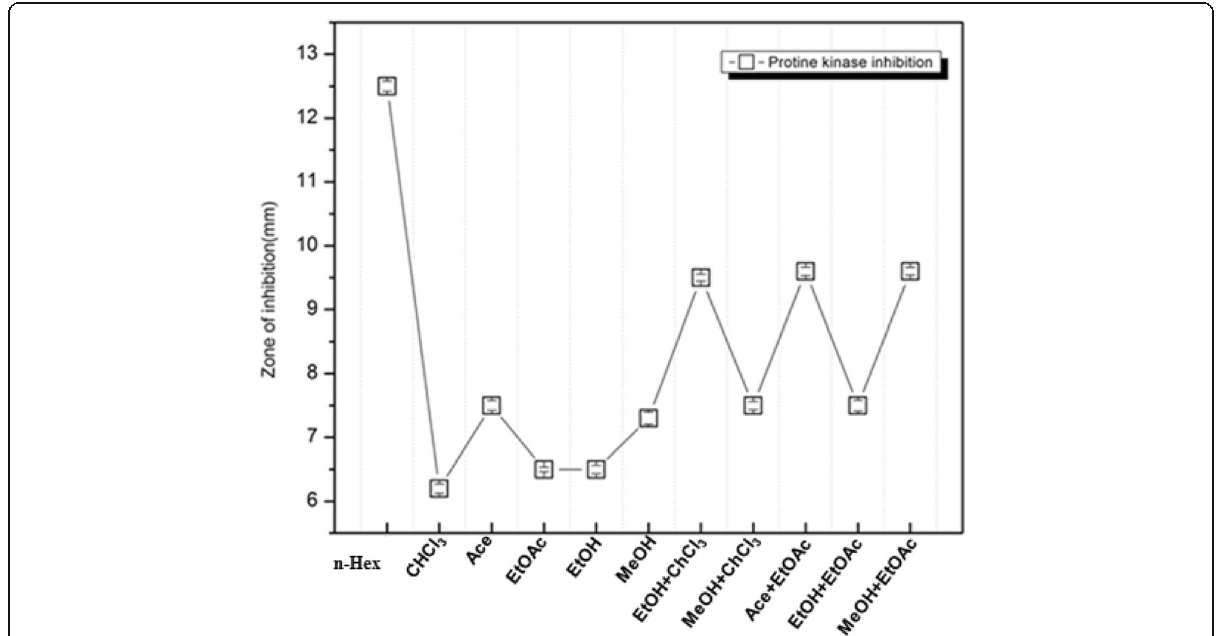
Fig. 4 Percent mortality (LC 50 μ g/ml) exhibited by different solvent extracts against L.